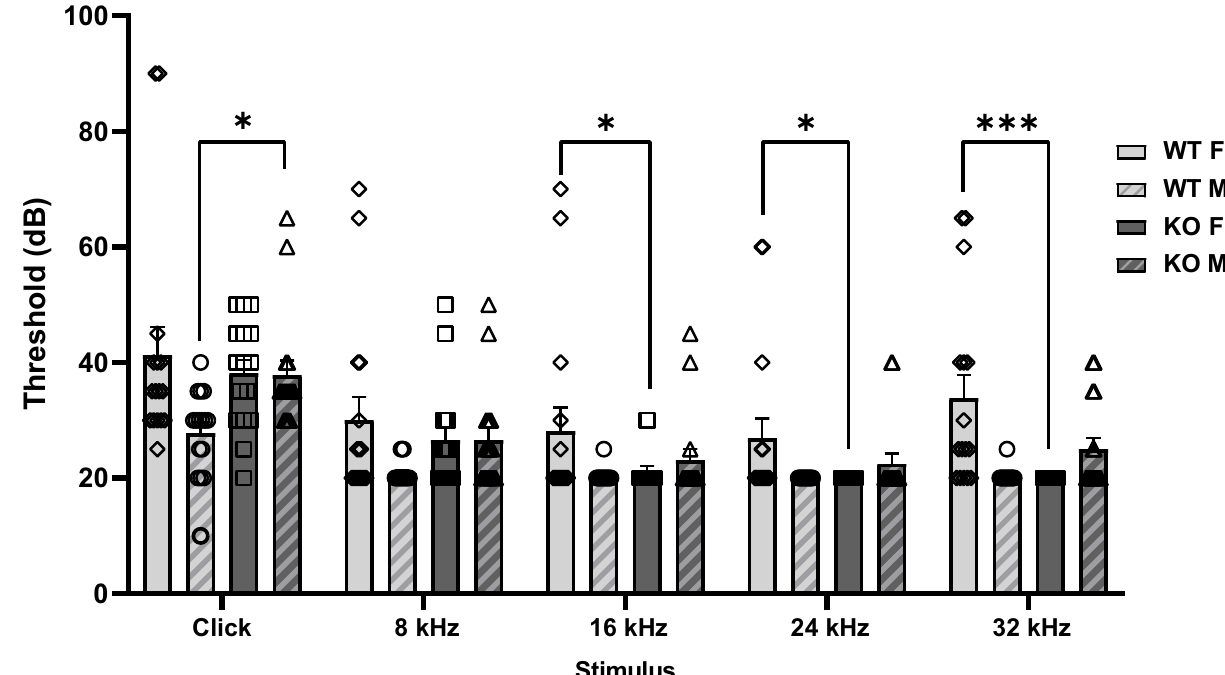
Fig 2. α 2 δ -4 KO mice exhibit sex-specific alterations in ABRs. Thresholds (dB) were plotted for WT and α 2 δ -4 KO mice in response to click and pure tone stimuli of the indicated frequencies. � p < 0.05; �� p < 0.01; ��� p < 0.001 by Kruskal-Wallis, Dunn’s test, linear mixed model, and estimated marginal